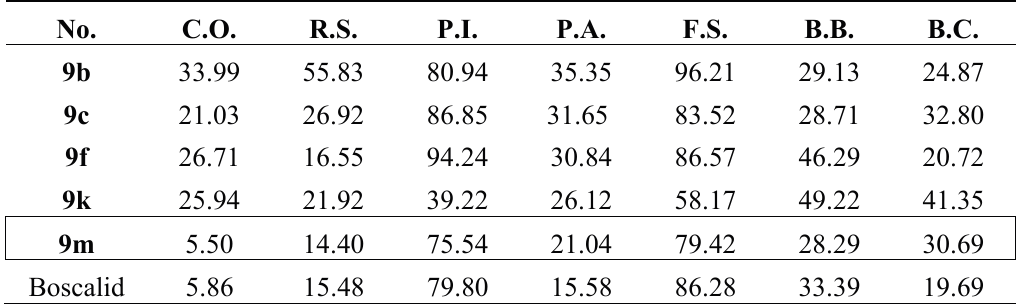
Table 2. EC 50 values of target compounds against seven fungi ( μ g·mL − 1